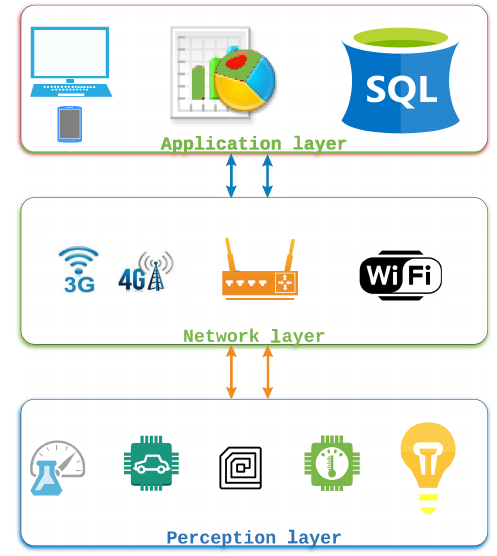
Fig. 1 Architecture of